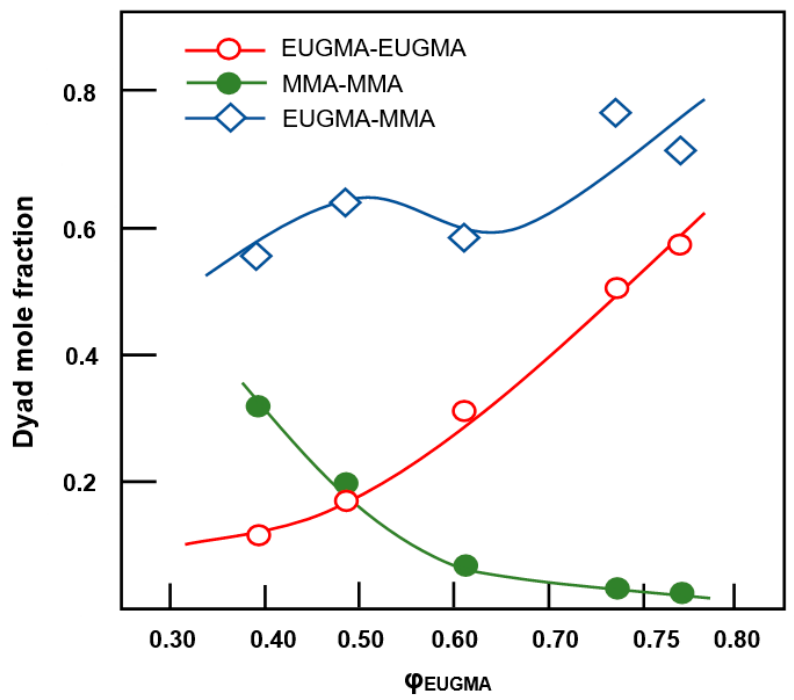
Figure 12. Distribution of dyad sequences in the copolymer vs. EUGMA mole fraction.